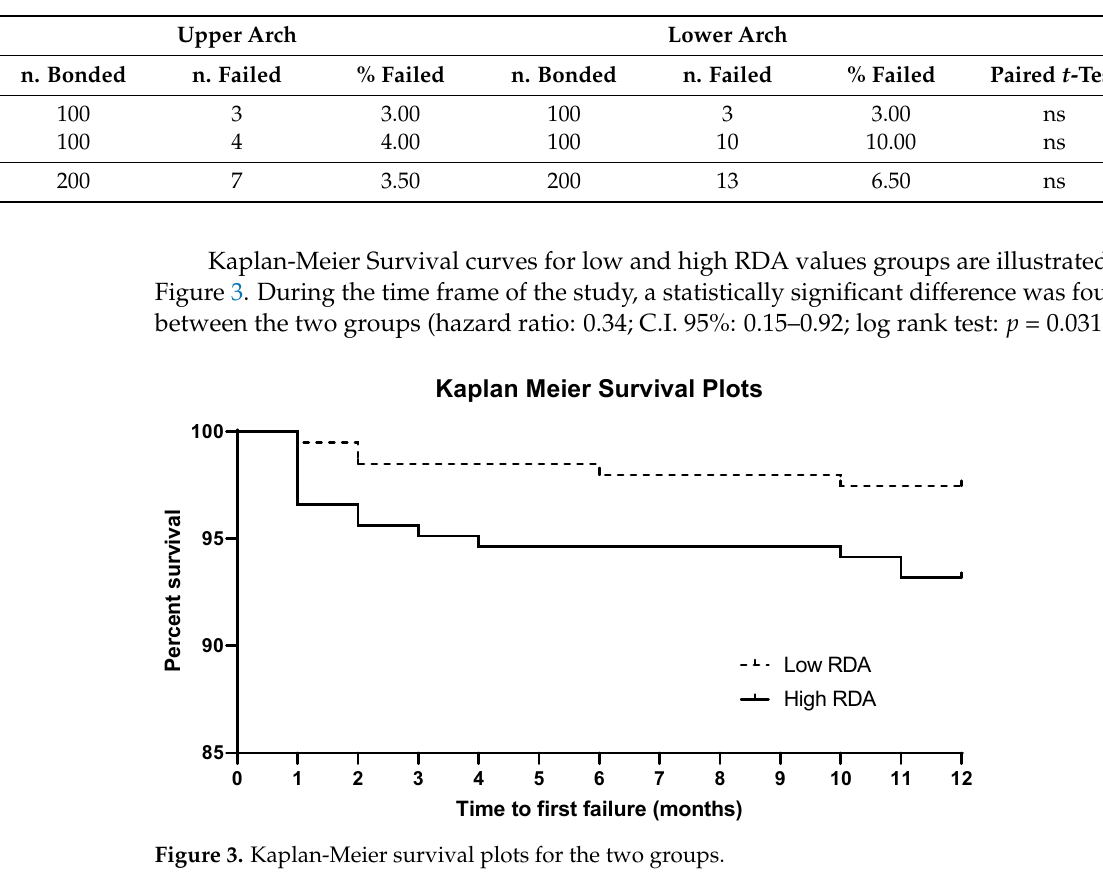
Table 8. Failure rates of brackets per arch (upper and lower).